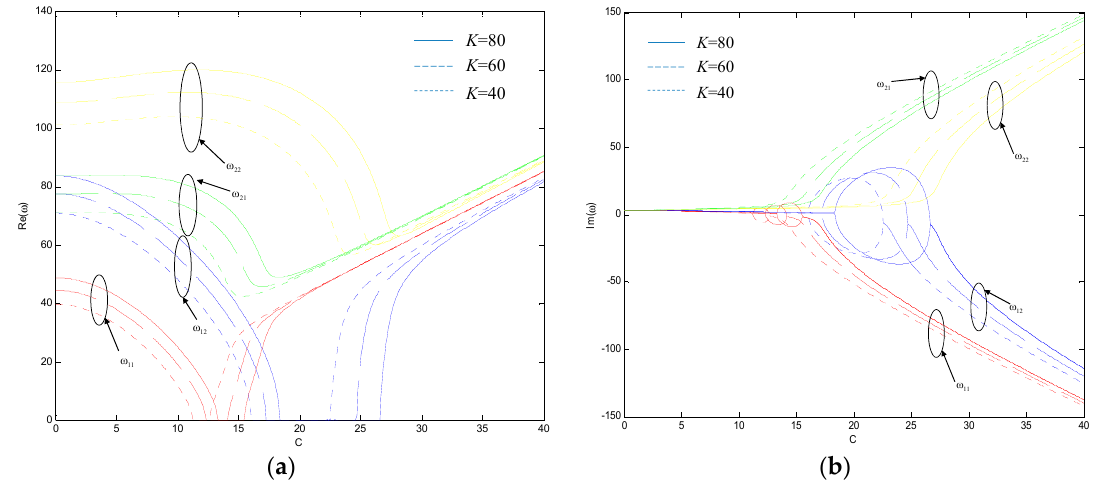
Figure 11. Effect of the small-parameter α on the divergence speed of the axially-moving nanoplate.